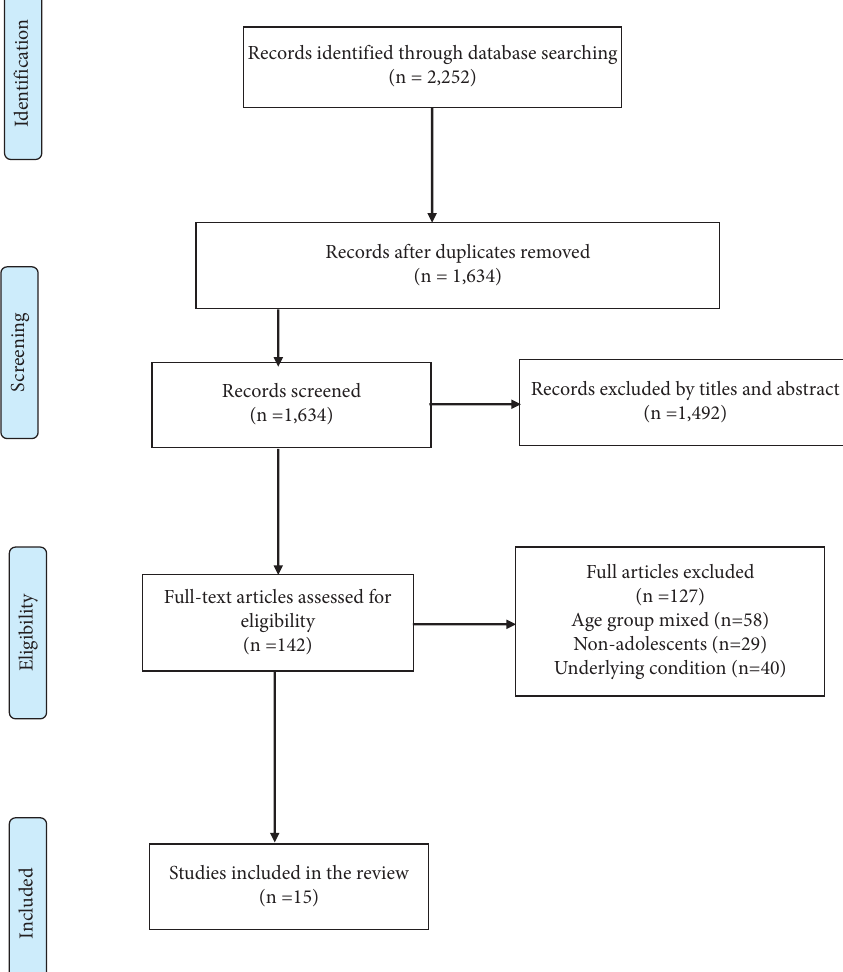
Figure 1: PRISMA diagram of the